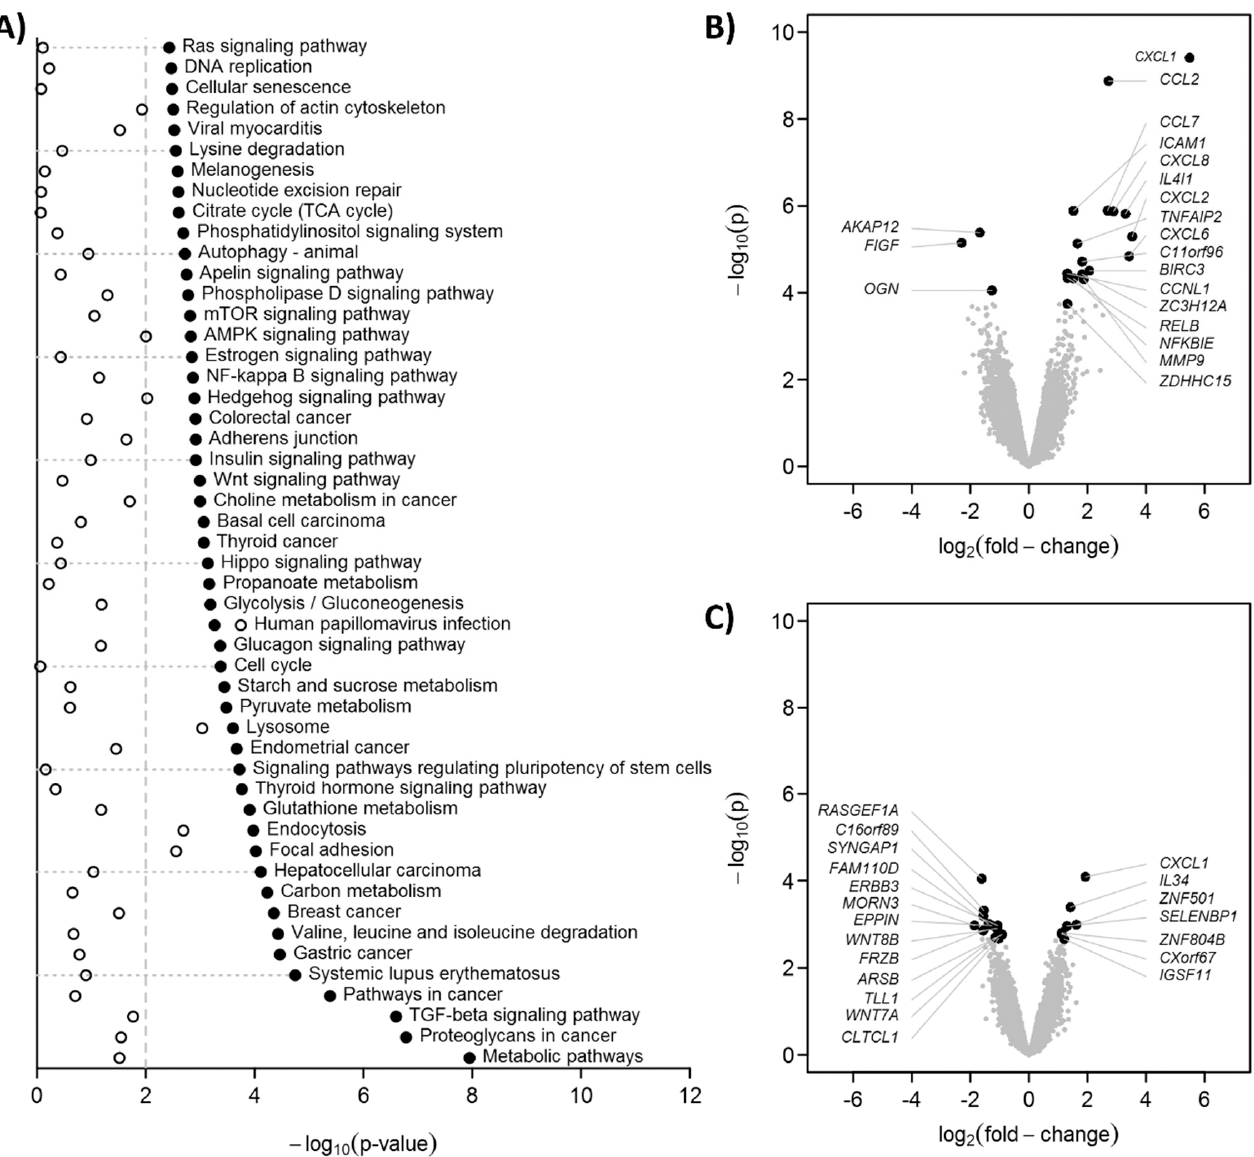
Figure 2. Gene expression profiling. huFib were stimulated with 500 ng/mL C0-C1f, 500 ng/mL C0-Linker for 24h. As controls (Ctrl) unstimulated huFib were harvested. Total mRNA was isolated and microarray analyses performed. ( A ) Statistical significances of the KEGG pathway analyses as − log 10 ( p ). The 50 pathways with lowest p -values in C0-C1f vs. control were selected. The vertical dashed line indicates p = 0.01. Black dots: C0-C1f vs. control, open circles: C0-linker vs. control. ( B , C ) Volcano plots for C0-C1f vs. control and C0-linker vs. control, respectively. The 20 genes with the lowest p -values are annotated.